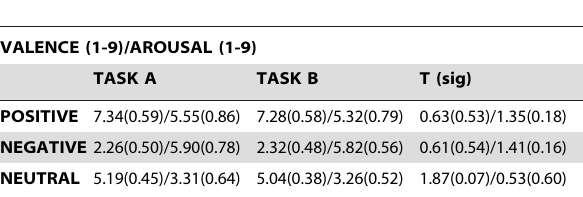
Table 1. Comparison of tasks A and B in terms of the representation of valence and arousal